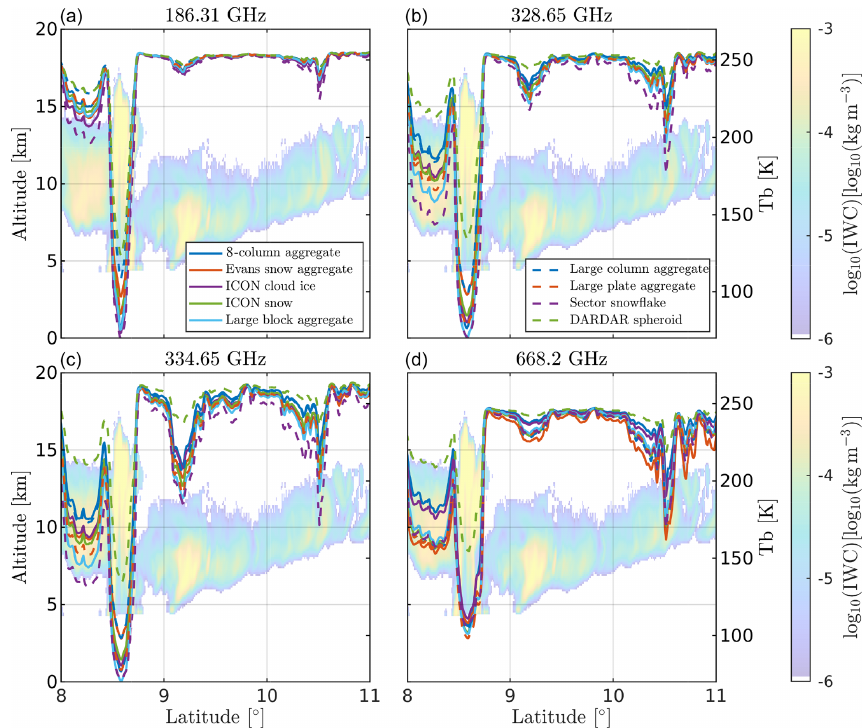
Figure 9. As in Fig. 8, but all panels use PSD F07T and the dBZ-based mode. The frequency is different in each panel. Frequencies are 186.31GHz (a) , 328.65GHz (b) , 334.65GHz (c) , and 668.2GHz (d)